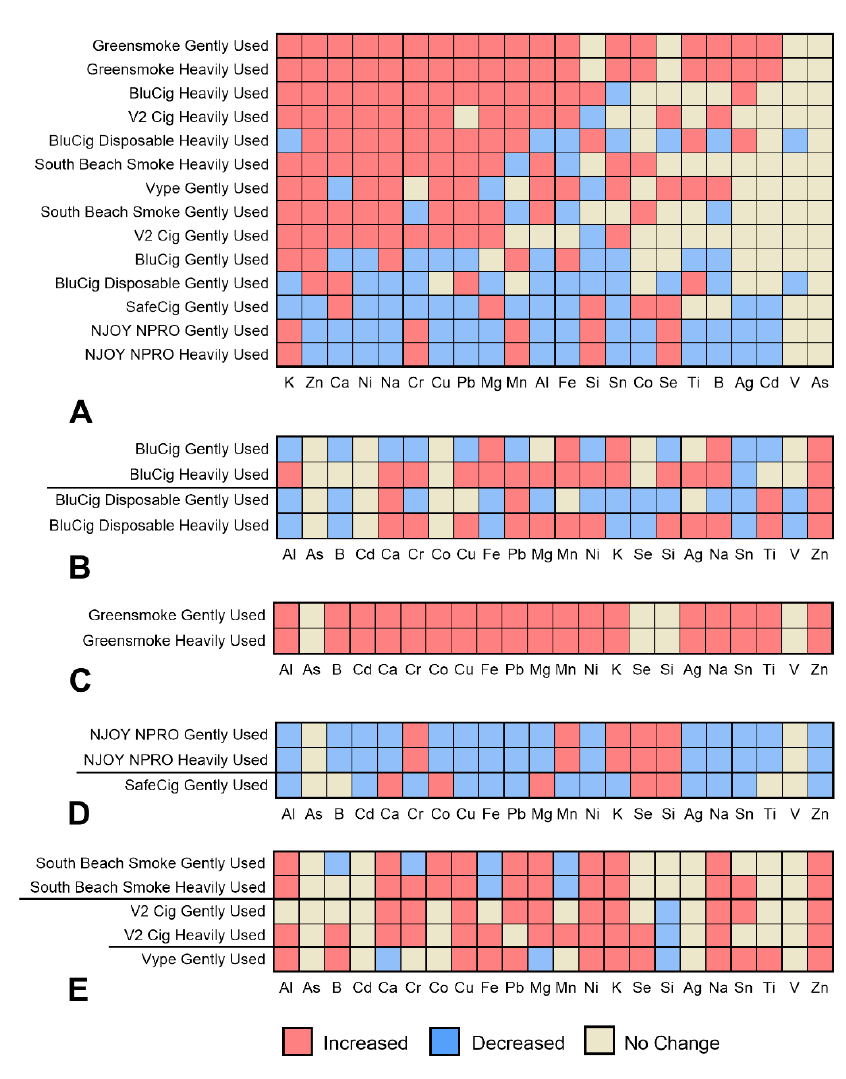
Figure 2. Heat map showing element concentrations in gently or heavily used ECs relative to the unused products. ( A ) Hierarchy of 10 brands (top to bottom) and 22 elements (left to right) where the concentration of gently or heavily used fluids increased in comparison to that of the unused. ( B ) Examples in which concentration increased in the heavily used compared to the gently used and unused fluid. ( C ) Brands in which both gently and heavily used fluid increased in concentration in comparison to unused fluid. ( D ) Brands in which concentrations of both gently and heavily used fluid decreased in comparison to that of the unused fluid, and ( E ) Brands in which changes in element concentration relative to that of the unused were similar in the gently and heavily used products. Red squares = increase; blue squares = decrease; tan squares = no change.